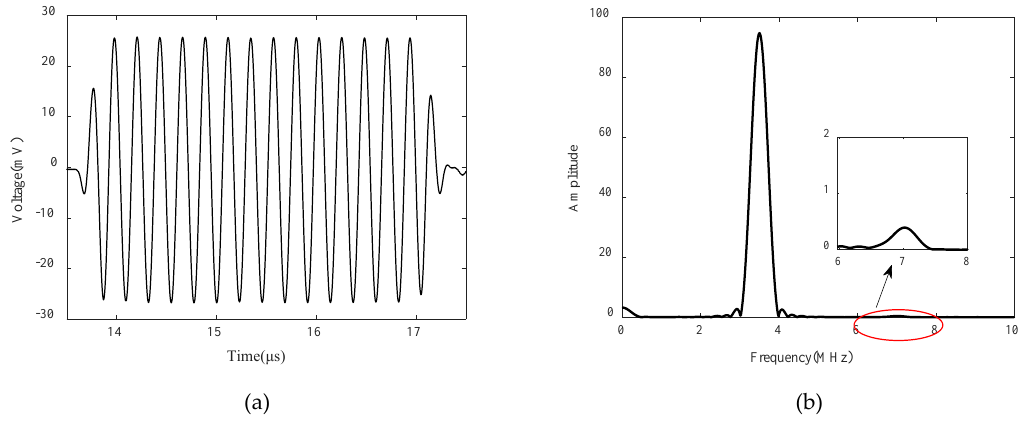
Figure 6. ( a ) A typical time domain signal and ( b ) its frequency properties. The signals at 3.5 and 7 MHz denote the fundamental and second harmonic wave amplitudes, respectively.